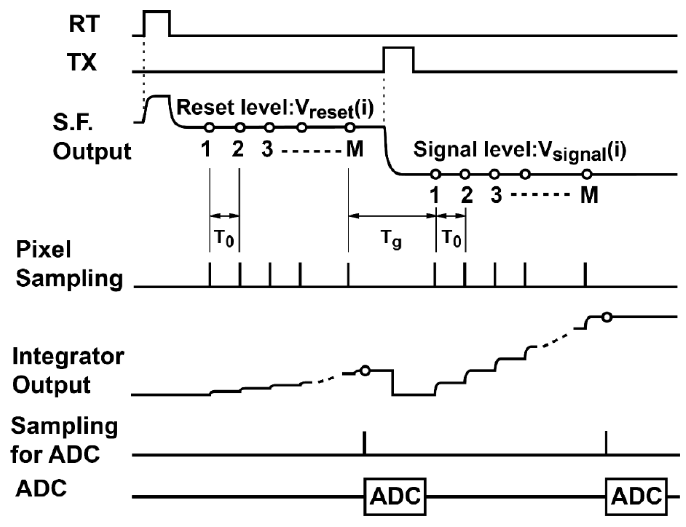
Figure 4. Timing diagram of the CMS.